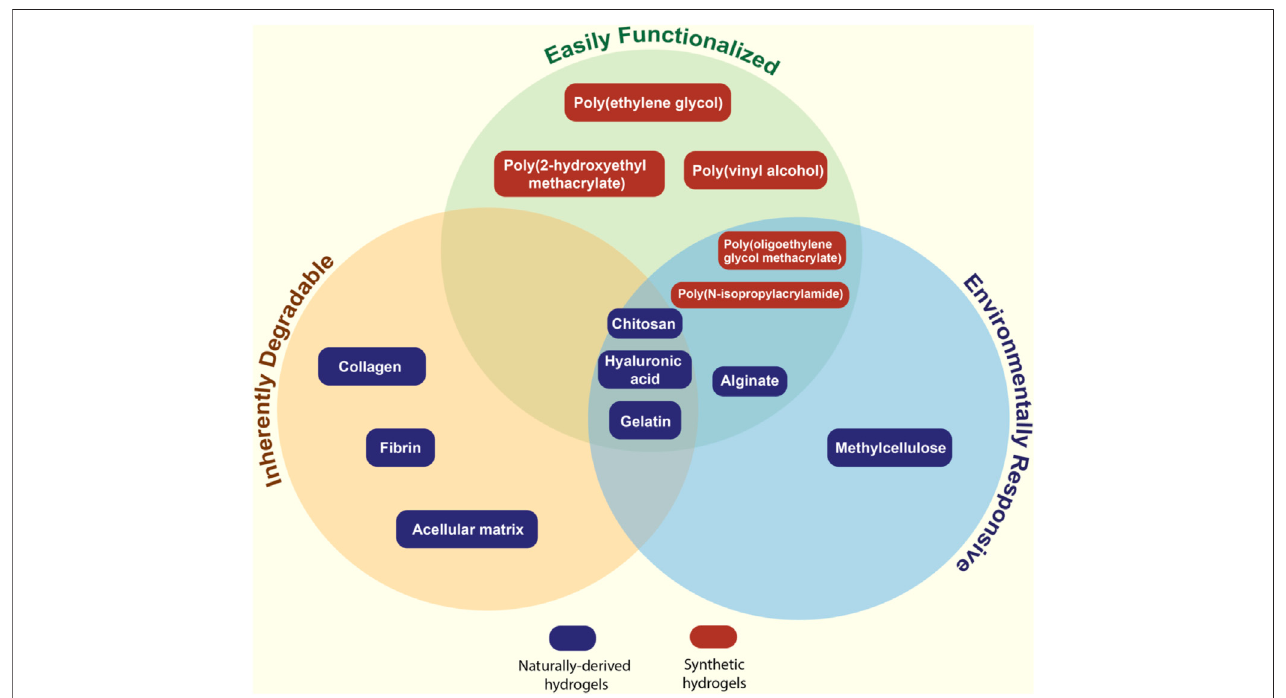
FIGURE 2 | Venn diagram describing the key properties of natural and synthetic polymers most commonly used for fabricating hydrogel-based tissue scaffolds.